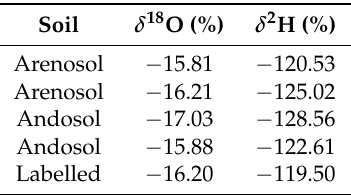
Figure 4. Comparison of isotopic signatures for laboratory measurements and for extracted water. Table 5. Summary of results for experiment C. δ 18 O and δ 2 H are relative to the Vienna Standard Mean Ocean Water